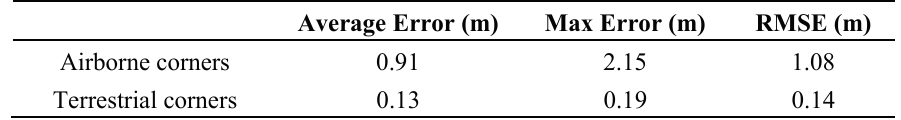
Figure 6. Building corner extraction from airborne and terrestrial LiDAR data. ( a ) Evaluation of extracted building contours from airborne LiDAR data; ( b ) extracted airborne corners; ( c ) evaluation of extracted building contours from terrestrial LiDAR data; ( d ) initial registration results of airborne corners and terrestrial corners. Table 2. Evaluation of the geometric precision of conjugate building